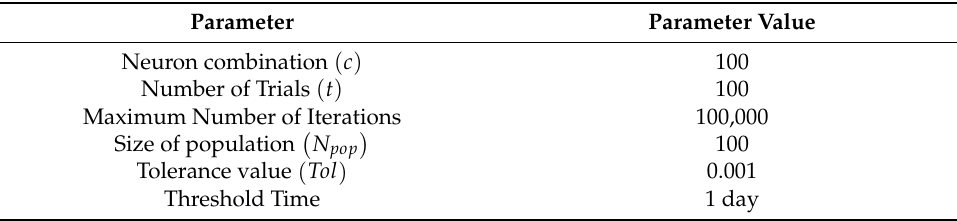
Table 2. List of parameters utilized in HNN-RAN3SATES